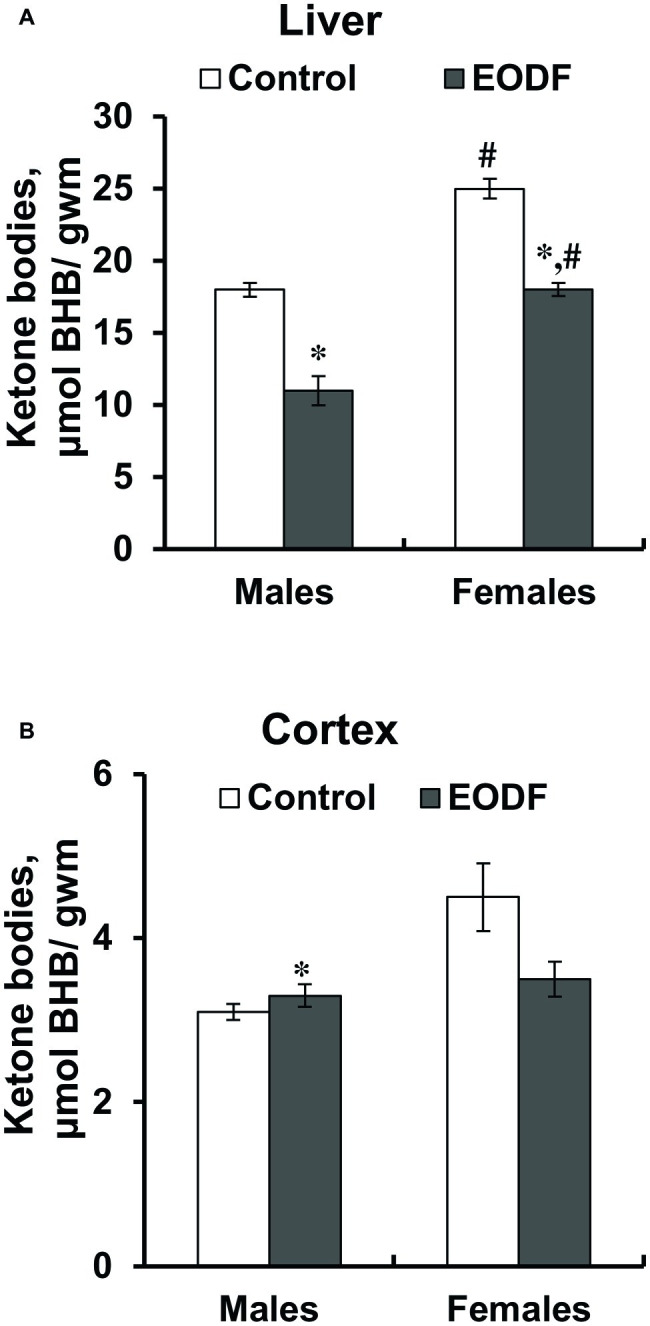
Concentrations of β-hydroxybutyrate (BHB) in liver the (A) and the cortex (B) of mice fed ad libitum (control) or subjected to an every-other-day feeding regimen (EODF) over 1 month, n = 5–6 mice. *Significantly different from the control group (p < 0.05), #significantly different from corresponding group of males (p < 0.05) by Welch’s t test with Benjamini-Hochberg adjustment of p.